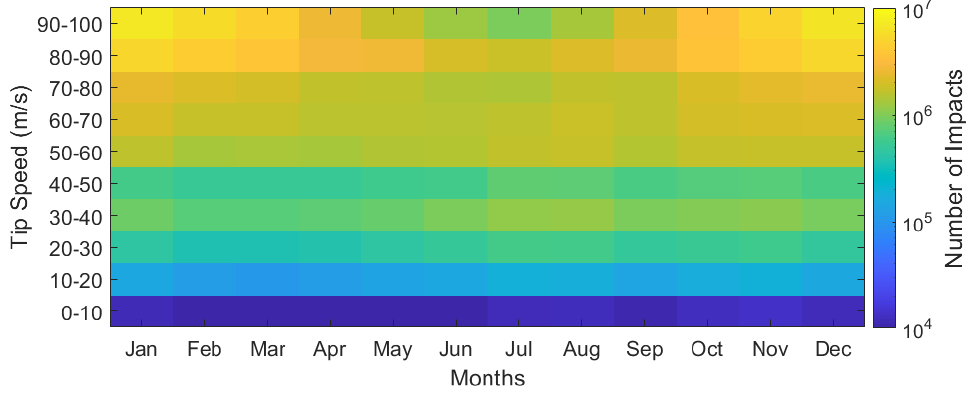
Figure 12. n A for each month, for each speed bin, as calculated.